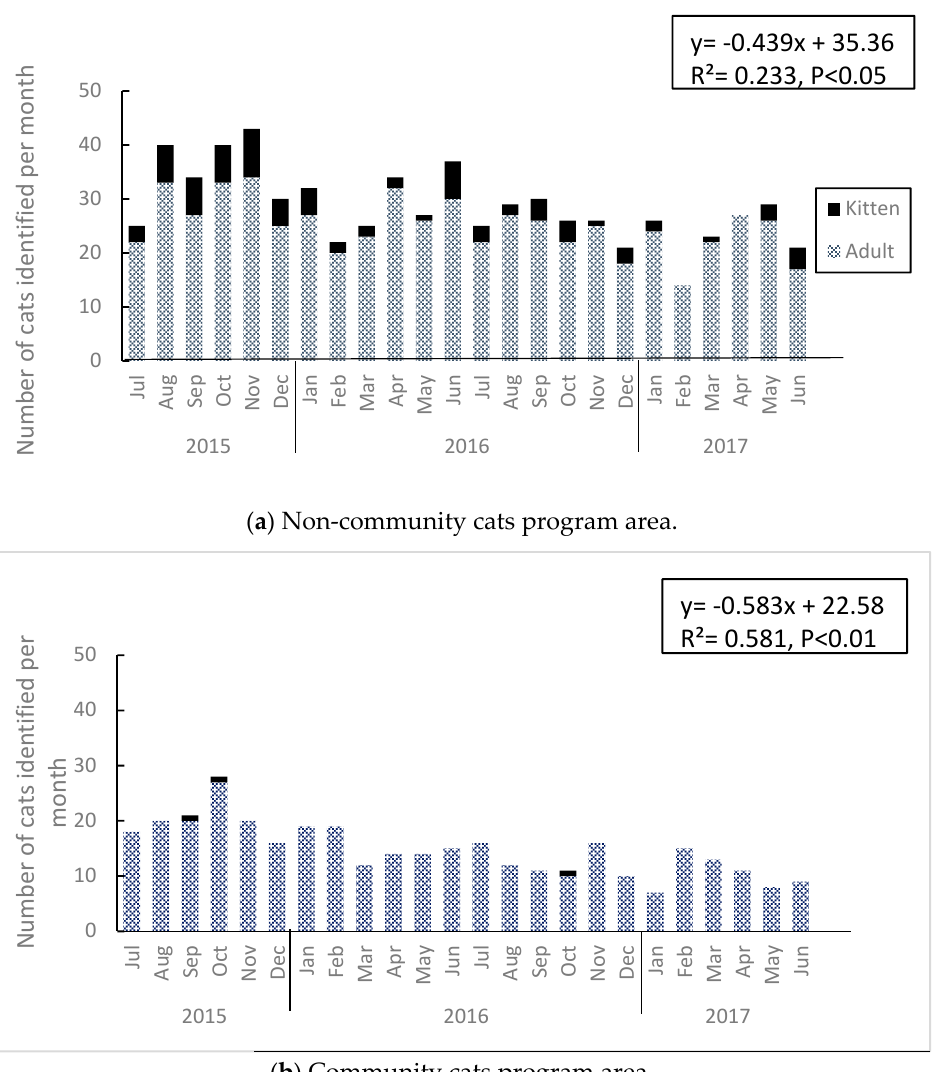
Figure 1. Variations in the number of free-roaming cats identified per month in the community cats program (CCP) area and non-CCP area from July 2015 to July 2017: ( a ) no-CCP area; ( b ) CCP area.